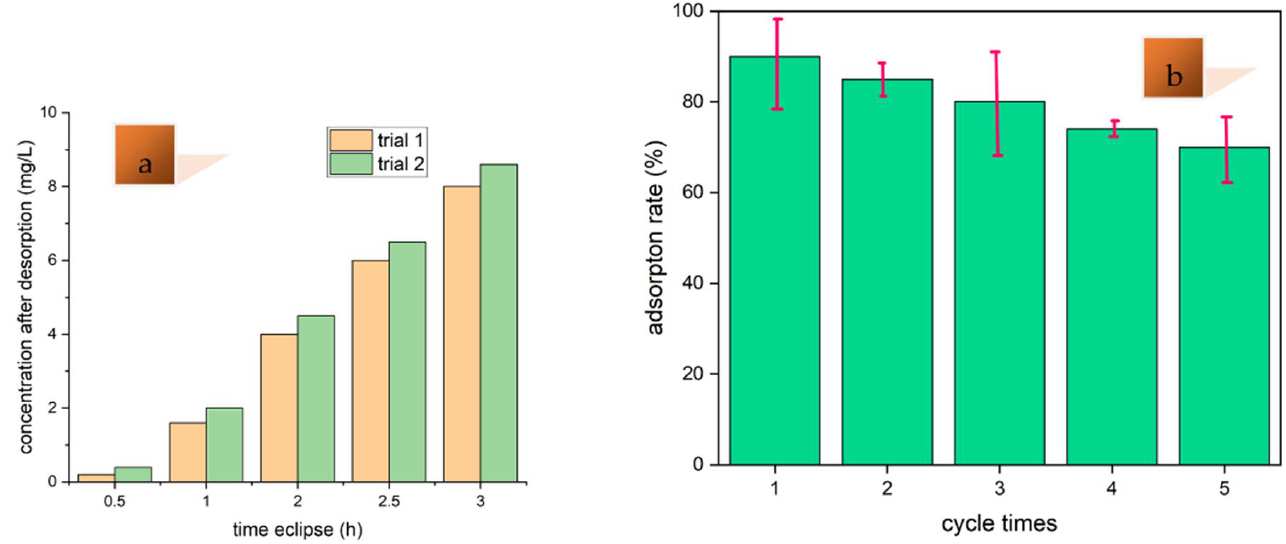
Figure 7. Desorption ( a ) and regeneration ( b ) study of sponge – La.